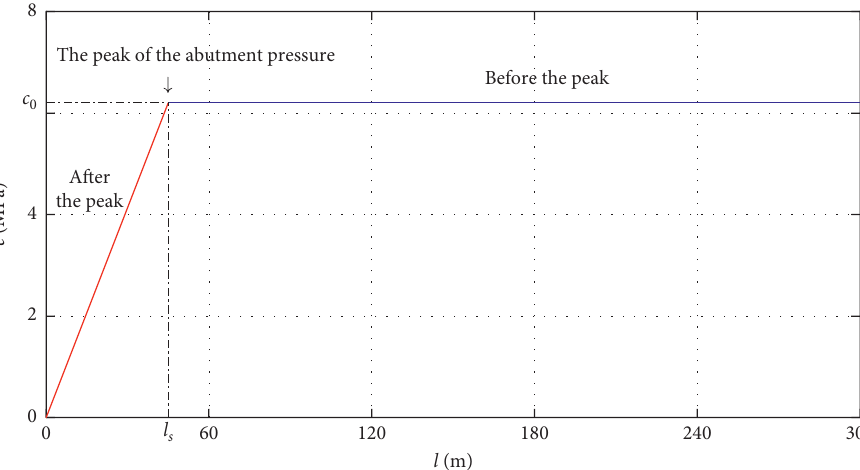
Figure 4: The cohesion of surrounding